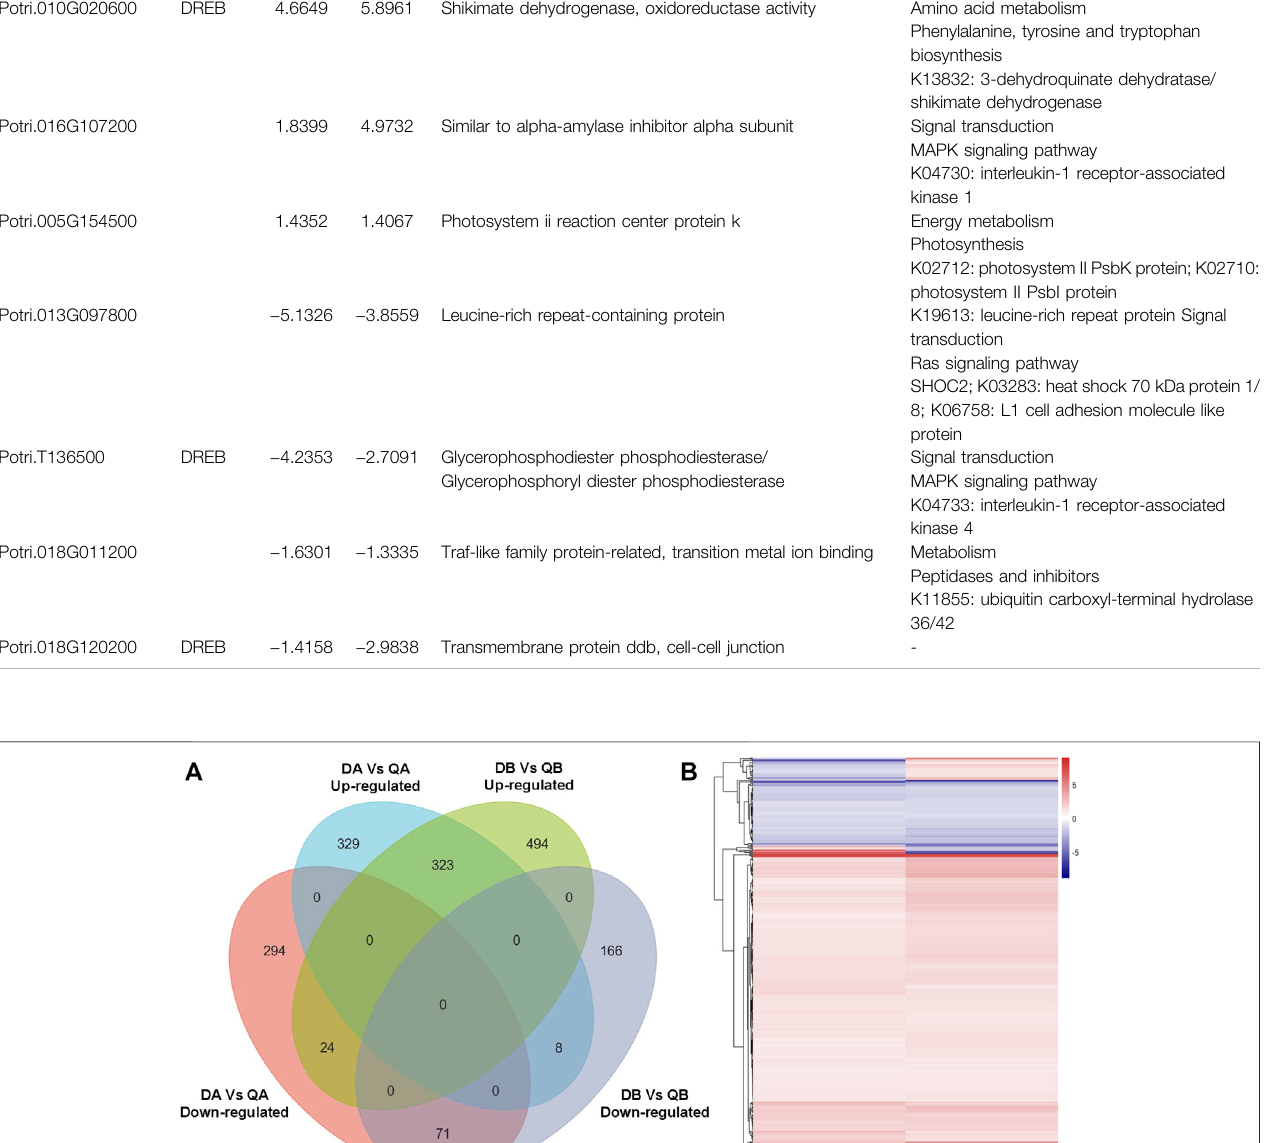
Frontiers in Bioengineering and Biotechnology |